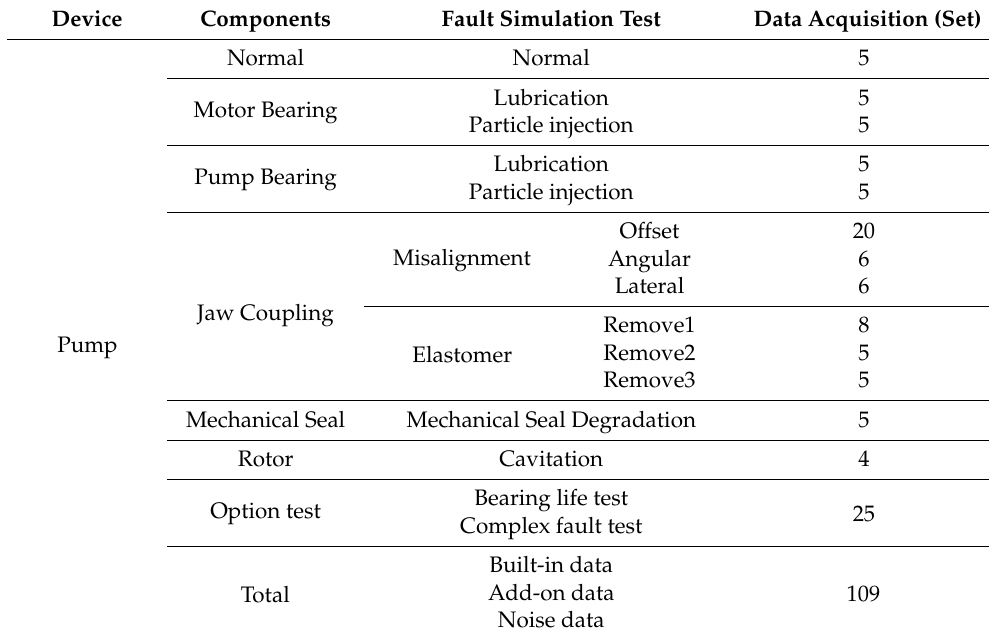
Table 3. Database development status of